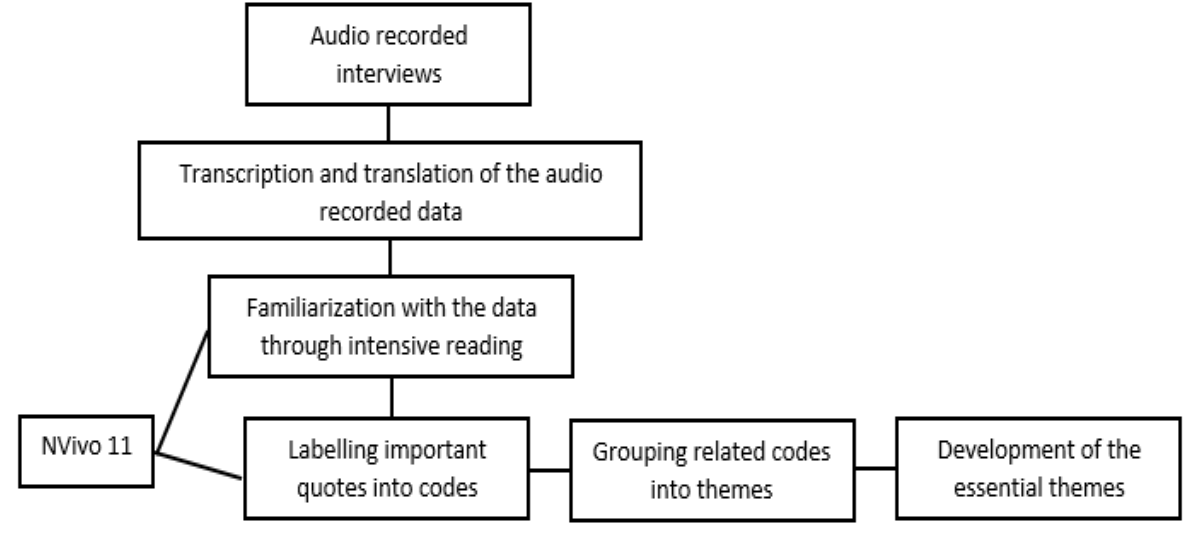
Figure 1. Process of data analysis.